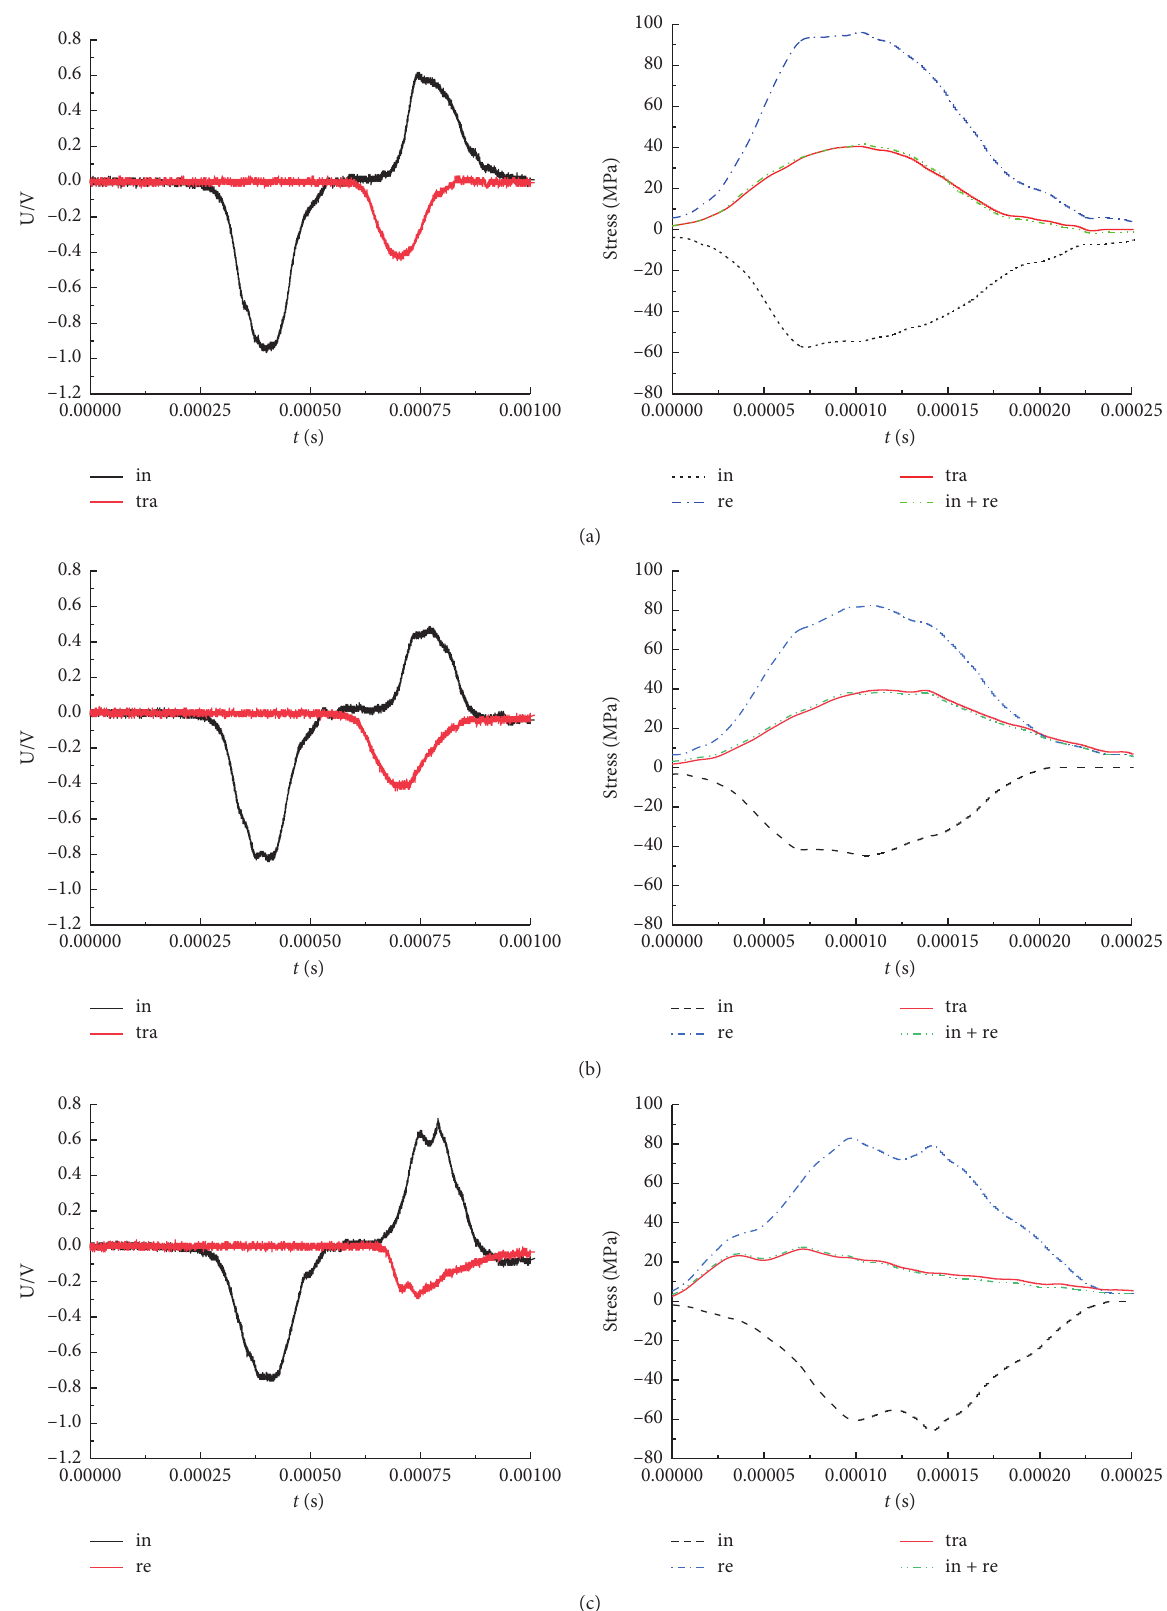
Figure 4: Waveform curve and stress equilibrium